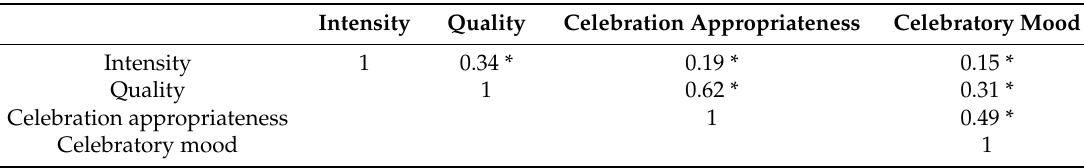
Table 4. Pearson correlation coefficients between wine ratings, over all conditions. * Indicates correlations that were significant at p < 0.01.